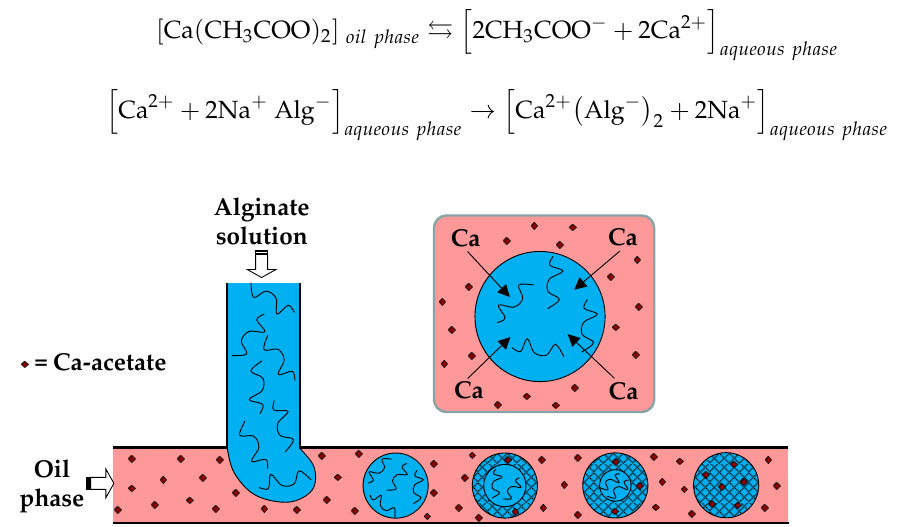
Figure 4. Formation of alginate beads by droplet generation in a T-junction, and the subsequent external gelation. The gelation is triggered by Ca-acetate, an oil soluble salt, which diffuses to the droplet interface and releases Ca 2+ ions by hydrolysis, according to Equation (5) [30]. The droplet gelation occurs first in the interfacial layer, resulting in a core−shell particle morphology, and then progresses towards the particle centre.